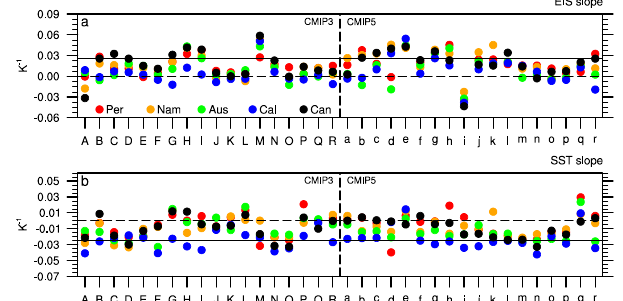
Figure 12. (a) The EIS slope (∂ LCC /∂ EIS ) ; (b) the SST slope (∂ LCC /∂ SST ) in the five oceanic regions from 36 models in the 20th century and from the observations. Note that the observational slope values (solid lines) are the averages over the five regions. Reprinted with permission from Qu et al.